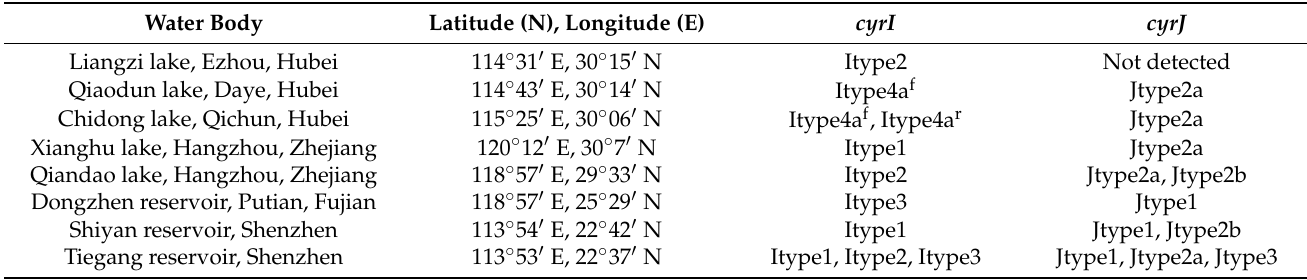
Table 1. Types of cyrI and cyrJ sequences from Chinese water